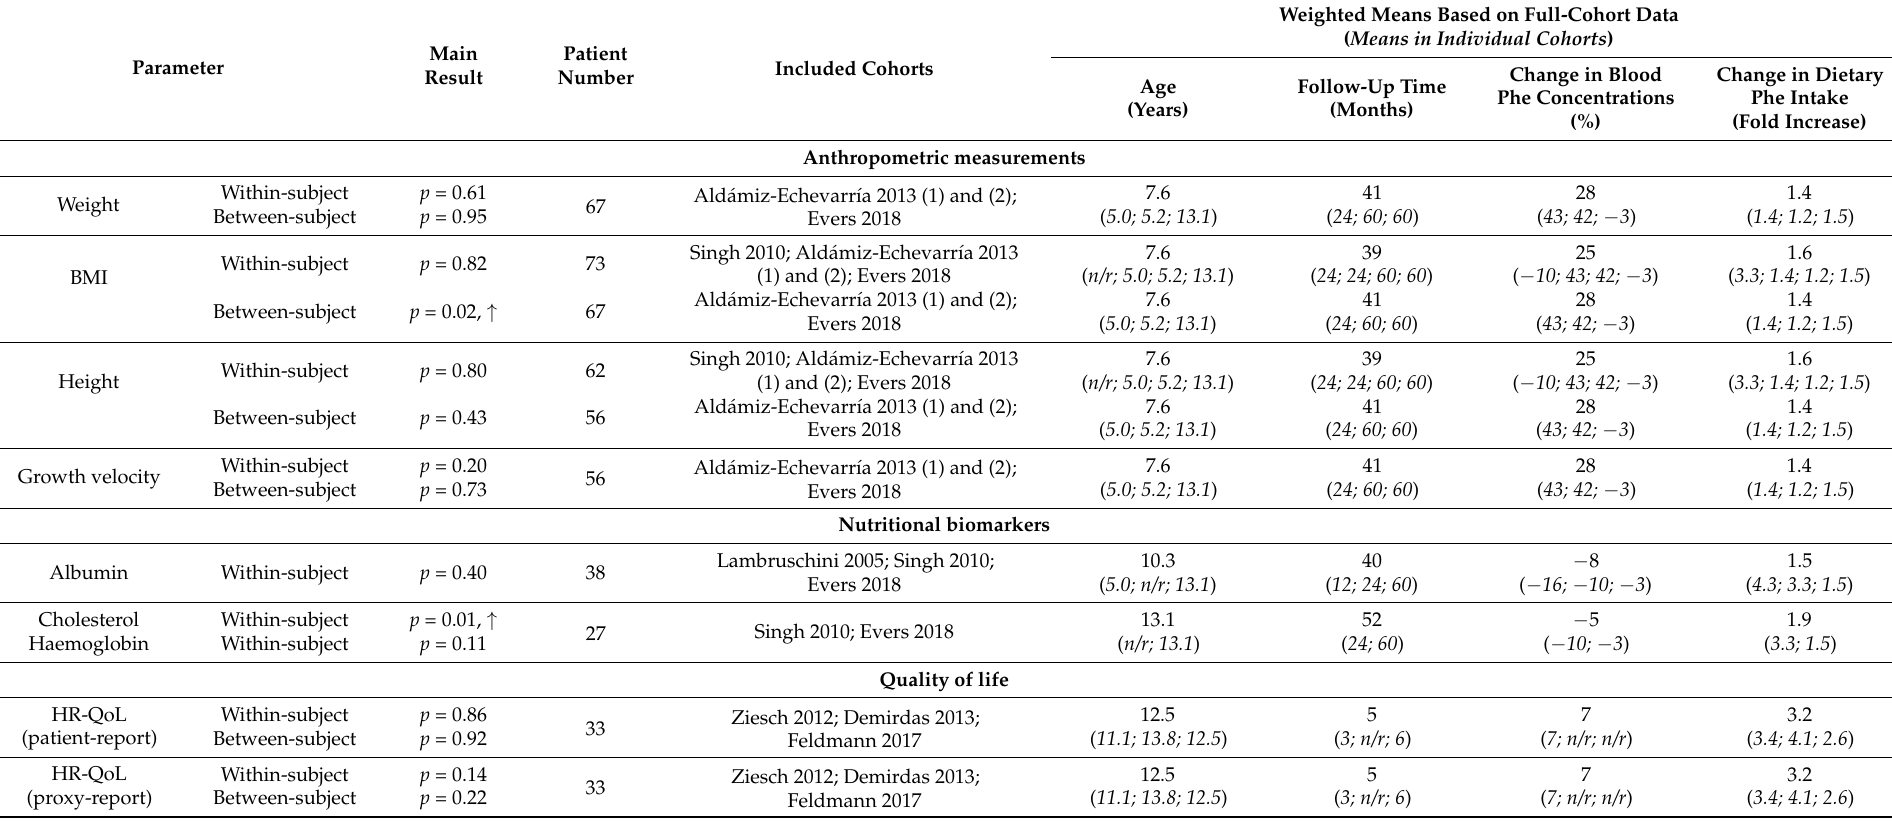
Table 1. Overview of the results from the primary meta-analyses. Means for cohort characteristics are weighted by the number of patients per cohort, and are based on full cohort data as presented in Table 2. ↑ , higher after BH4 treatment (within-subject analysis) or higher in BH4-treated patients after follow-up compared to a control group (between-subject analysis). N/r, not